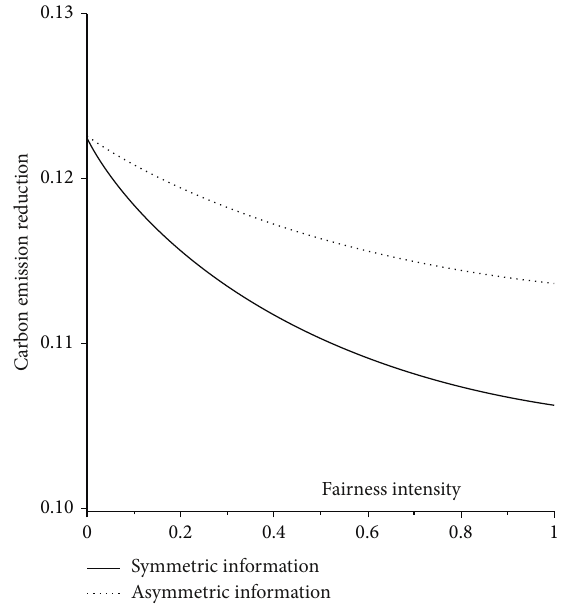
Figure 3: Sensitivity of carbon emission reduction to fairness